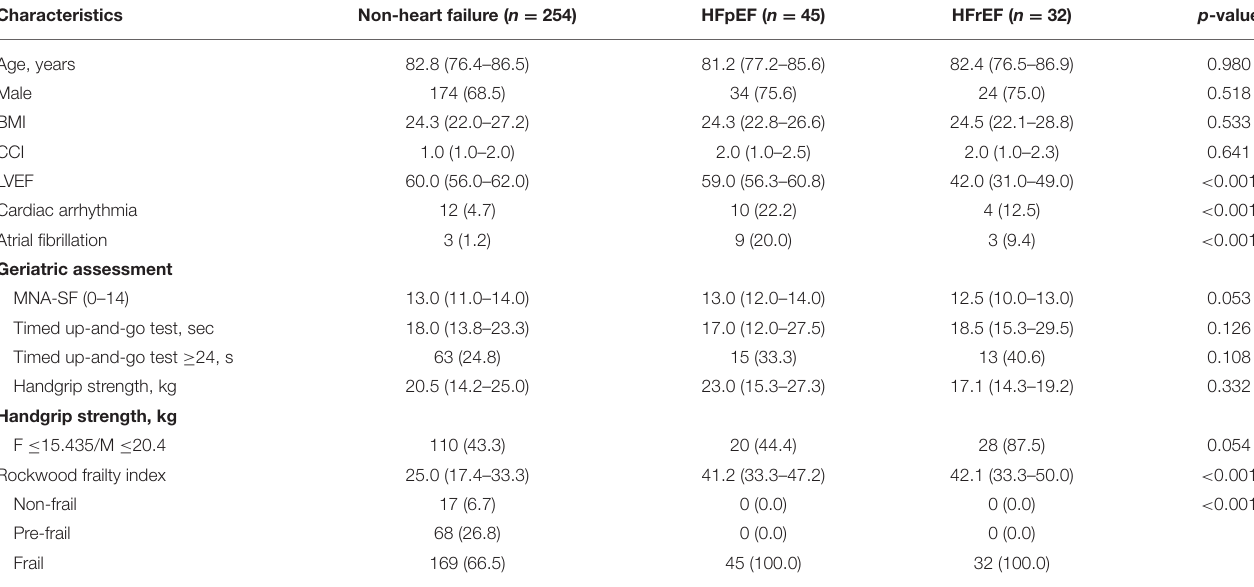
TABLE 3 | Comprehensive geriatric assessment in older CKD patients with and without heart failure.